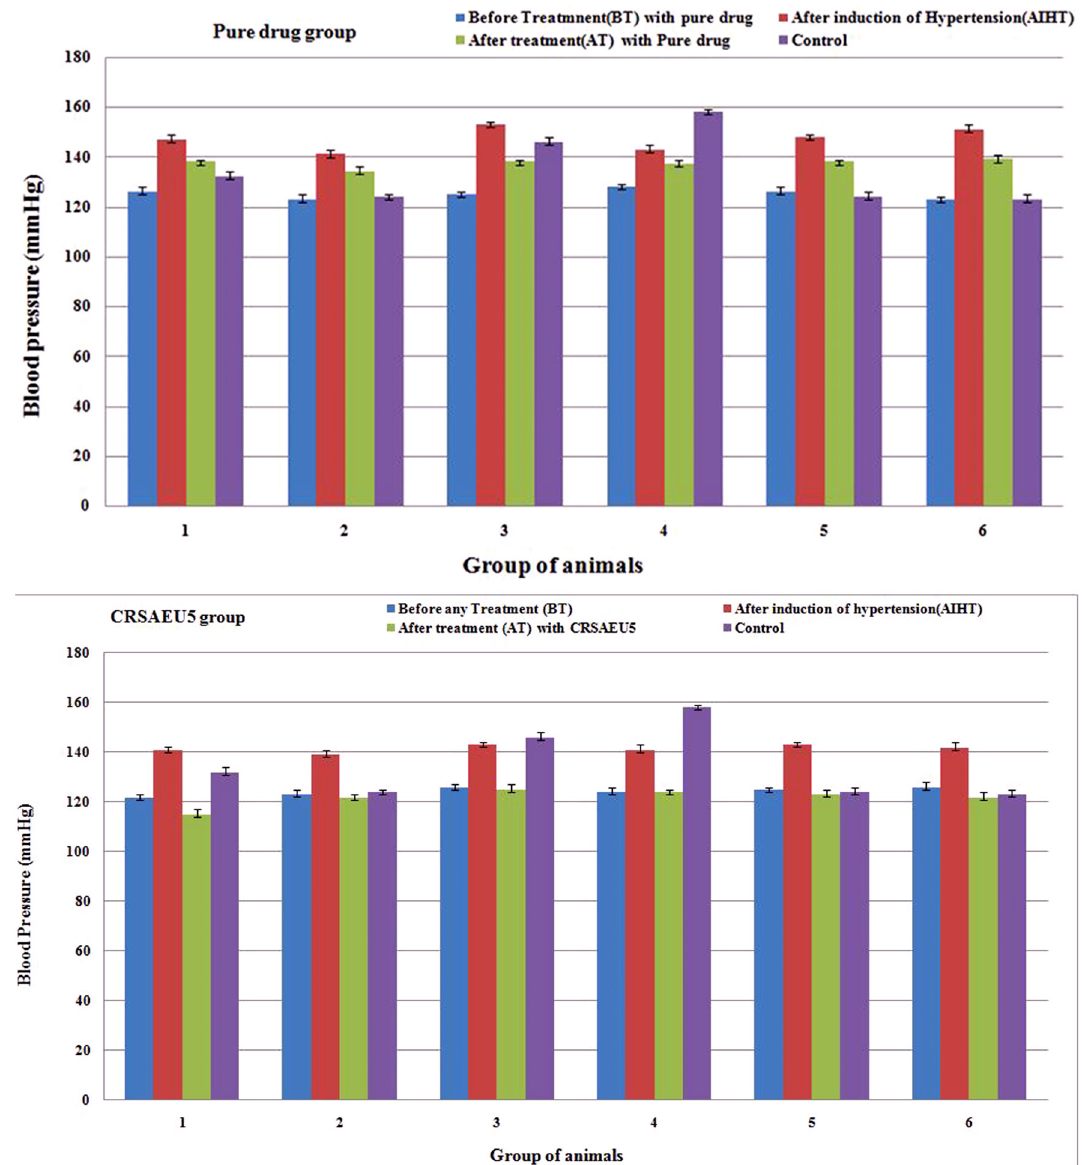
FIGURE 9 – In vivo studies of hypertension in